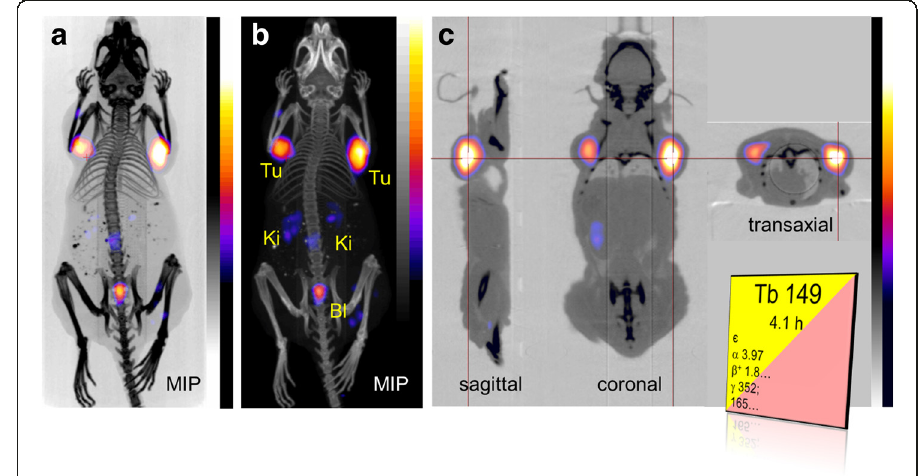
Fig. 1 PET/CT images of an AR42J tumor-bearing mouse 2 h after injection of 149 Tb-DOTANOC (7 MBq). ( a , b ) Maximal intensity projections (MIP) and ( c ) sections showed distinct accumulation of radioactivity in tumor xenografts (Tu) and residual radioactivity in kidneys (Ki) and urinary bladder (Bl). The decay scheme of 149 Tb is shown as in the Karlsruhe Nuclide Chart